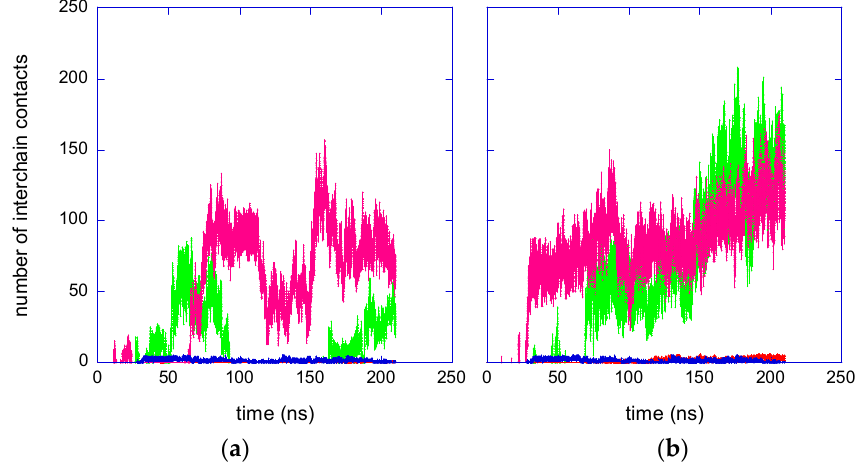
Figure 2. Number of inter-chain contacts in the PNIPAM solutions. Hydrophobic contacts for the atactic and isotactic-rich stereoisomers are displayed in pink and green, respectively. Contacts between N and O atoms for the atactic and isotactic-rich stereoisomers are displayed in red and blue, respectively: ( a ) T = 283 K; ( b ) T = 323 K.